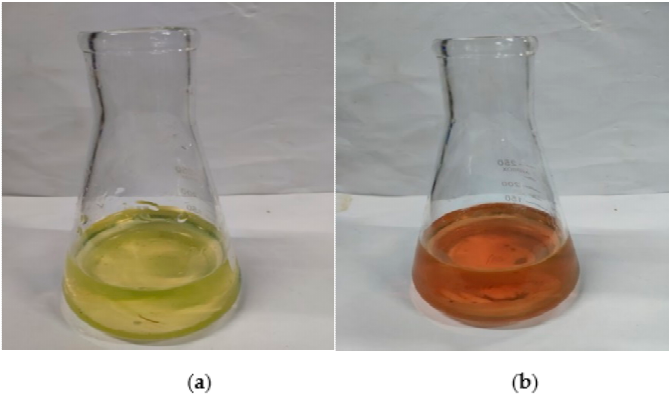
Figure 2. Color change of solution before and after titration: ( a ) color before titration; ( b ) color after titration.